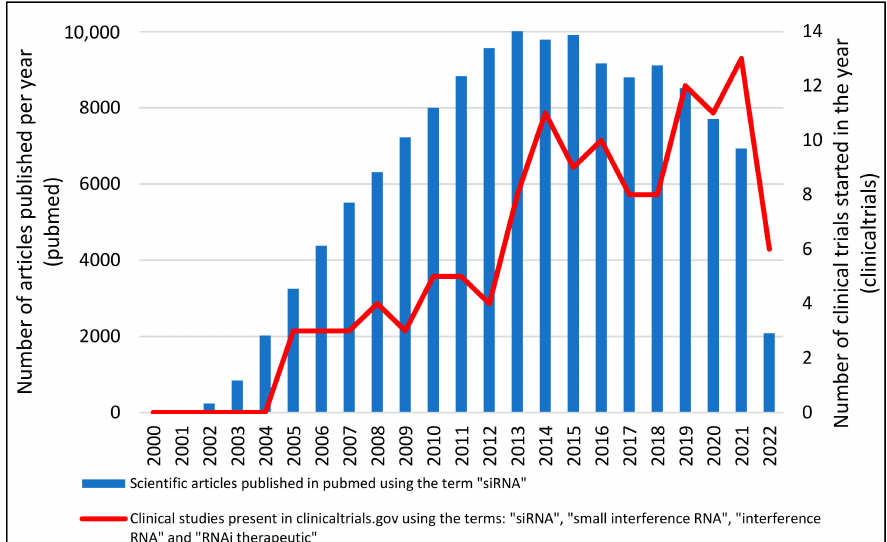
Figure 2. Number of articles and Clinical Studies about siRNA between 2000 and 2021. Data was obtained from the number of clinical trials present in clinicaltrials.com (accessed on 7 March 2022) using the terms: “siRNA”, “small interference RNA”, “interference RNA” and “therapeutic siRNA”. After data collection, duplicate data were